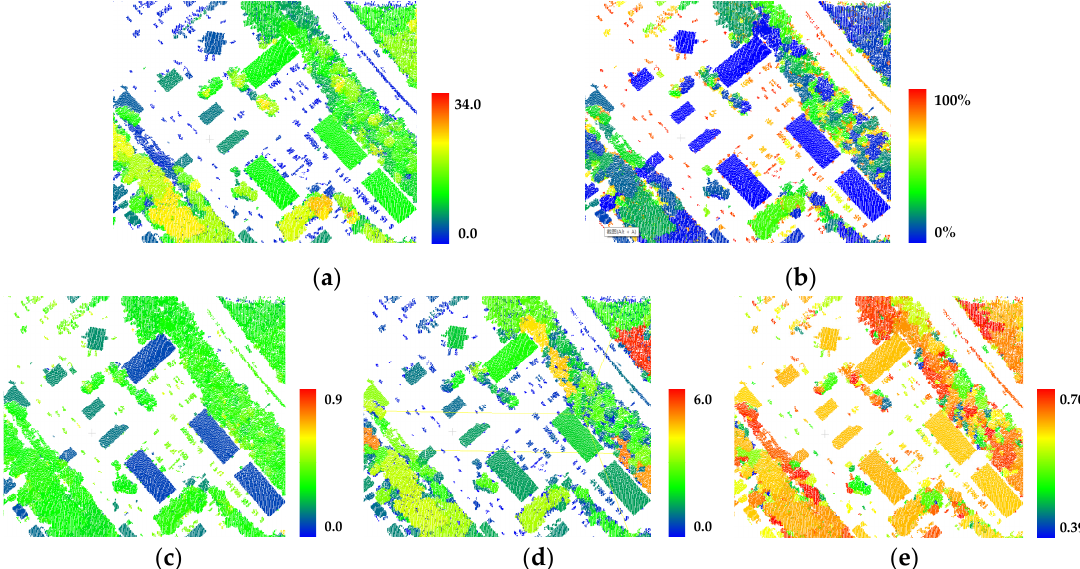
Figure 4. Cluster-based features: ( a ) height F H ; ( b ) distribution of ground points F G ; ( c ) roughness F R ; ( d ) compactness F C ; ( e ) normal correlation F N